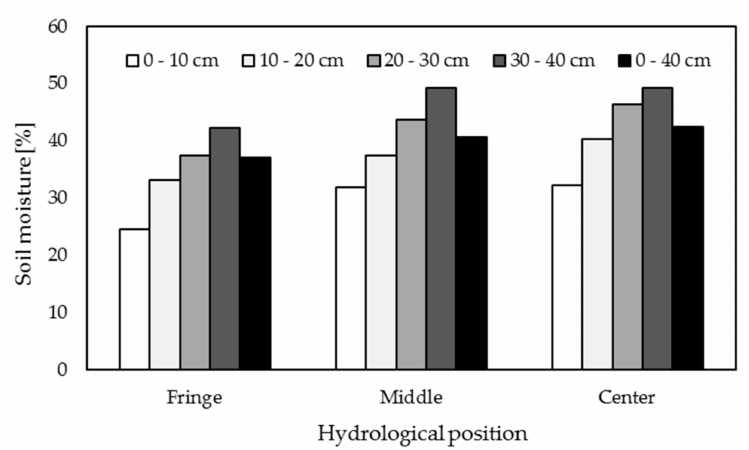
Figure 3. Mean soil moisture content along the soil profile at di ff erent hydrological positions of the inland valley. Data adopted from Gabiri et al. 2018 [20].